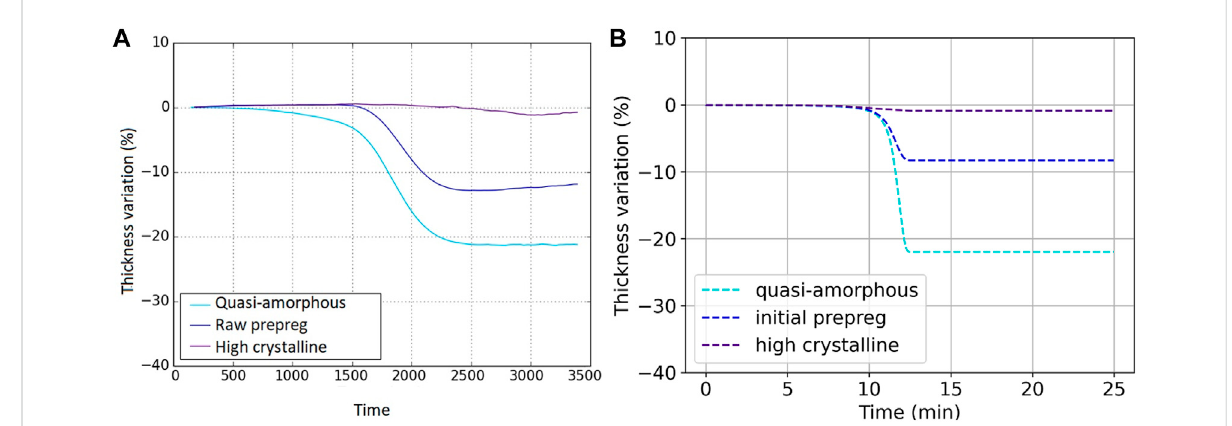
FIGURE 10 ComparativethicknessevolutionsatTginfunctionofcrystallinitydegreeforexperimentaldataandmodelpredictions. (A) Experimentaldata (B) Model predictions.